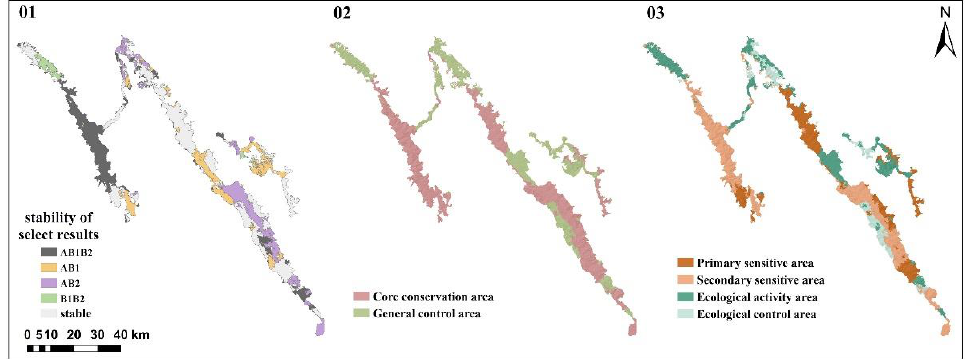
Figure 8. 01, Sensitivity analysis test; 02, First-level functional zoning; 03, Second-level functional